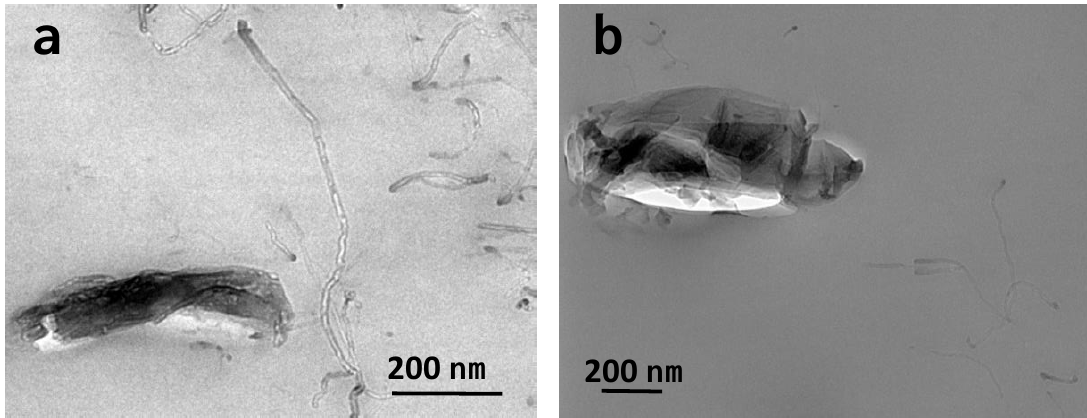
Figure 9. ( a ) SEM of the sample filled with 3 wt% of LDH-CNT and IL and ( b ) SEM of the sample filled with 3 wt% of LDH-CNT without IL.